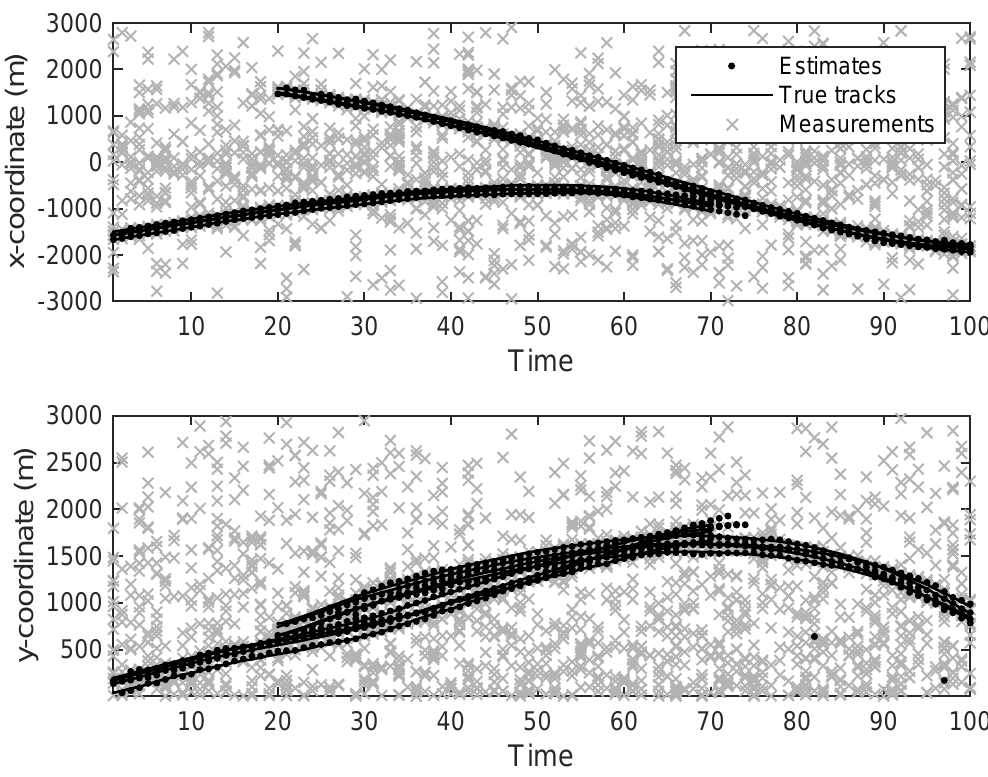
Figure 6. The state estimation by Generalized Labeled Multi-Bernoulli (GLMB)